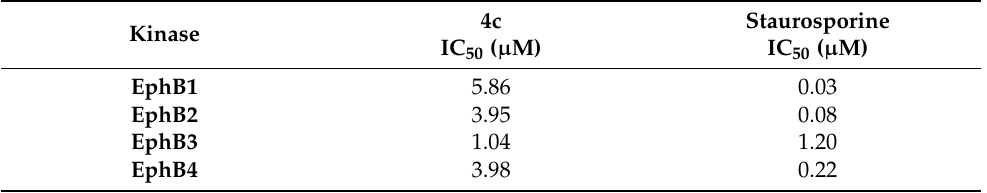
Table 7. IC 50 values of compound 4c over the EphB isoforms.